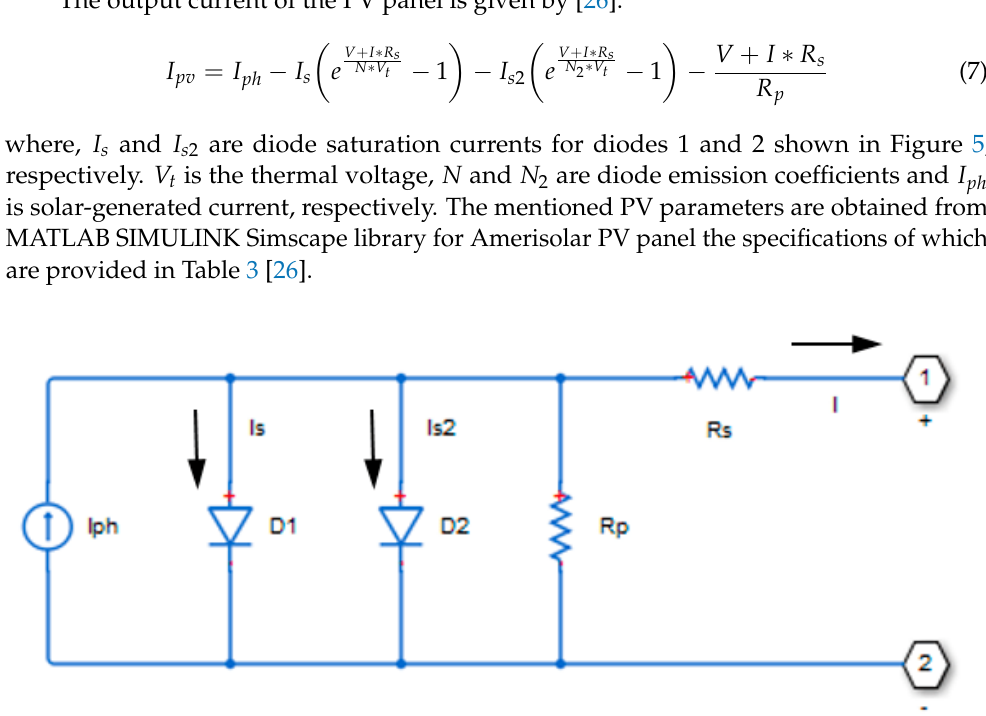
Figure 6. The accelerated ageing profile and RTP test for degradation analysis of the Nissan Leaf second life battery. 0